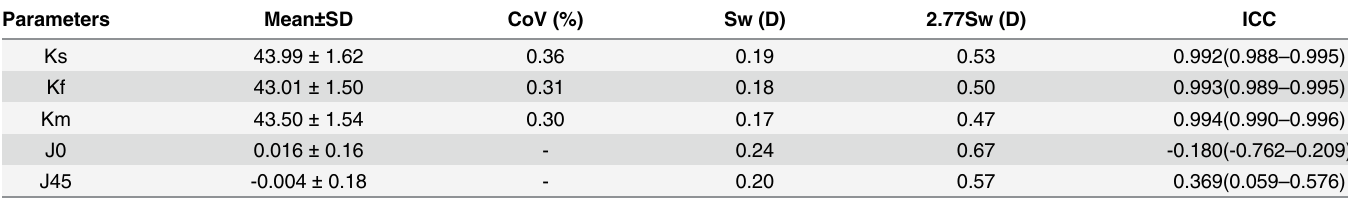
topographers: i.e., Topcon KR-1W and iTrace. In the present study, we evaluated the intraob- server repeatability and interobserver and intersession reproducibility, and agreement in mea- surements of corneal power and astigmatism by Topcon KR-1W and iTrace, and we then compared the results with those obtained by Topolyzer and IOLMaster. Our data showed good intraobserver repeatability and interobserver and intersession reproducibility of corneal power measurements (i.e., Ks, Kf and Km) obtained by Topcon KR-1W and iTrace, with low Sw (no more than 0.26 D), low CoV (no more than 0.44%), and high ICC values (all above 0.99%). In contrast, the intraobserver repeatability and interobserver and intersession reproducibility of corneal astigmatism measurements (i.e., J0 and J45) obtained by Topcon KR-1W and iTrace were poor with low ICC values (no more than 0.45). This suggested that corneal astigmatism measurements obtained by Topcon KR-1W and iTrace should be viewed with caution in clini- cal applications because of the poor repeatability and reproducibility of J0 and J45. In the present study, for the intraobserver repeatability assessment of Ks, Kf and Km, the CoV, 2.77Sw and ICCs of Topcon KR-1W were within 0.19% to 0.34%, 0.40 D to 0.68 D, and 0.993 to 0.997 (Table 1), respectively, compared with those of iTrace which were within 0.32% to 0.50%, 0.49 D to 0.70 D, and 0.991 to 0.996 (Table 4), respectively. For the interobserver reproducibility assessment of Ks, Kf and Km, the CoV values were within 0.20% to 0.22% (Table 2), compared to those within 0.23% to 0.30% (Table 5). For the intersession reproduc- ibility assessment of Ks, Kf and Km, the CoV and 2.77Sw values of Topcon KR-1W were within 0.16% to 0.19%, and 0.21 D to 0.26 D (Table 3), respectively, compared with those of iTrace which were within 0.30% to 0.36%, and 0.47 D to 0.53 D (Table 6), respectively. We concluded that Topcon KR-1W had better repeatability and reproducibility than iTrace for Ks, Kf and Km measurements. There have been several studies that assessed the repeatability and reproducibility of corneal power measurements obtained by Placido-disc based corneal topographers, and in only a few cases had the repeatability and reproducibility of corneal astigmatism measurements been assessed by means of vector analysis. Mao et al.[36] evaluated the Placido-disk based corneal topographer Keratogragh 4, which had excellent intraobserver repeatability and interobserver Table 6. The intersession reproducibility of Ks, Kf, Km, J0 and J45 obtained by iTrace. (Note: D: diopter, SD: standard deviation, Sw: within-subject standard deviation, CoV: within-subject coefficient of variation, ICC: intraclass correlation coefficient.)